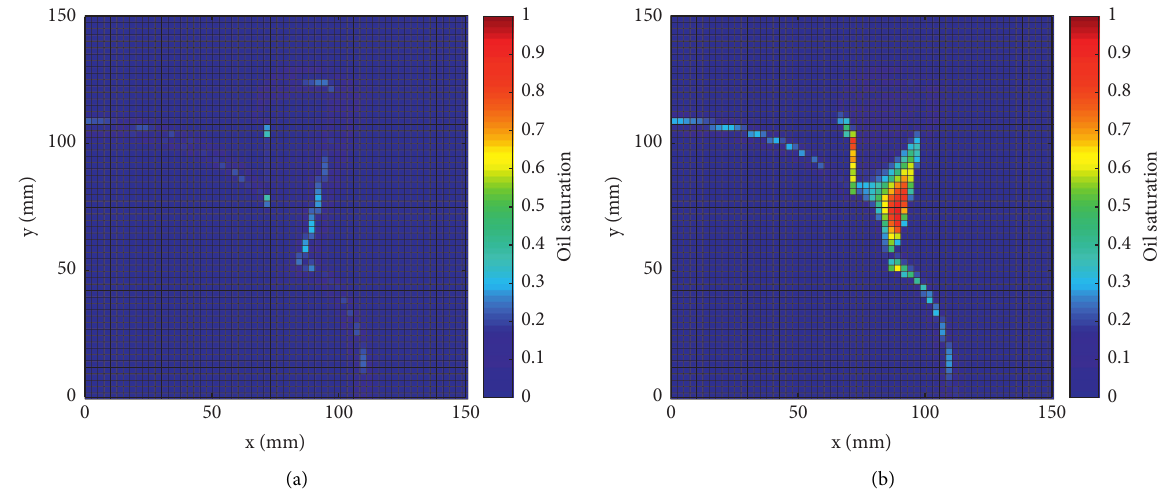
Figure 14: Oil saturation error profiles after mesh refinement for (a) pIEDFM and (b) EDFM after 1800seconds of injection.